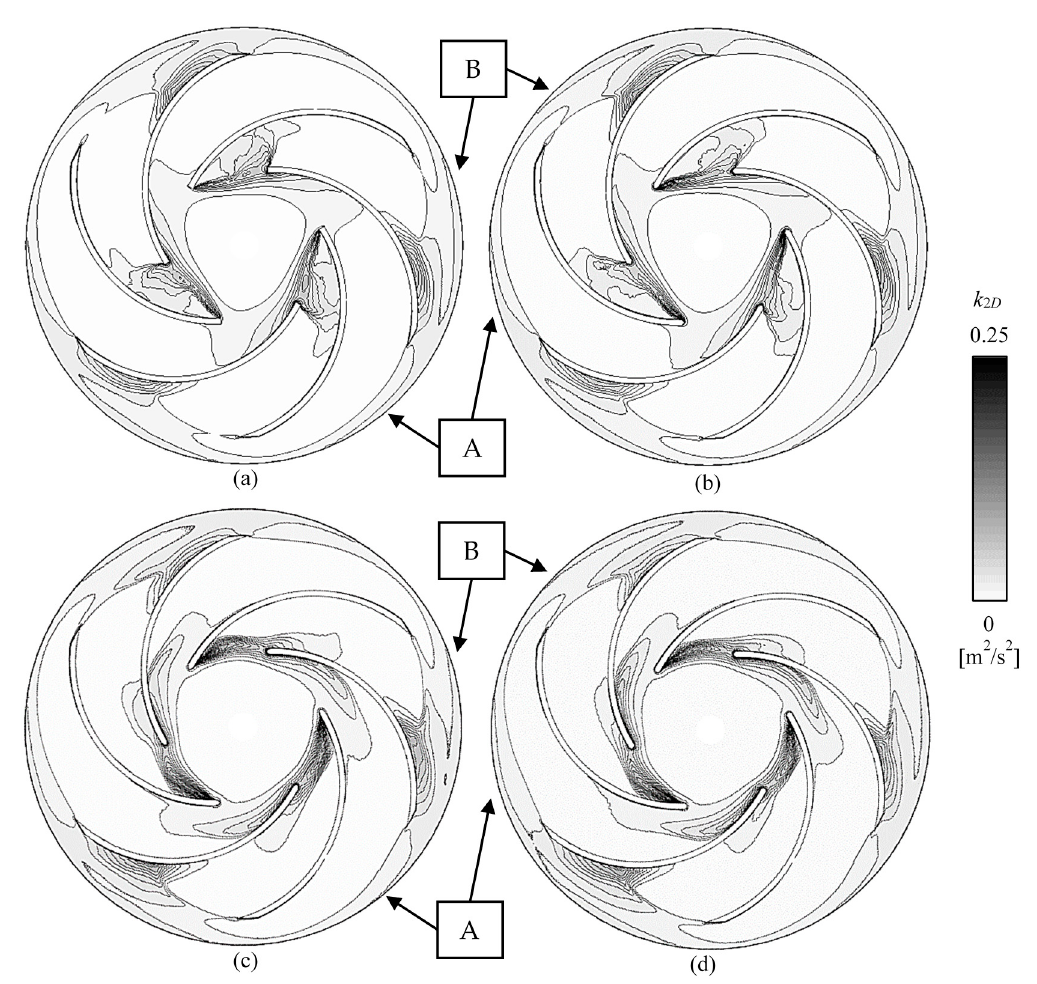
Figure 12. Contour of the turbulence kinetic energy k 2 D : ( a ) blunt, ( b ) sharp, ( c ) round, and ( d ) ellipse.